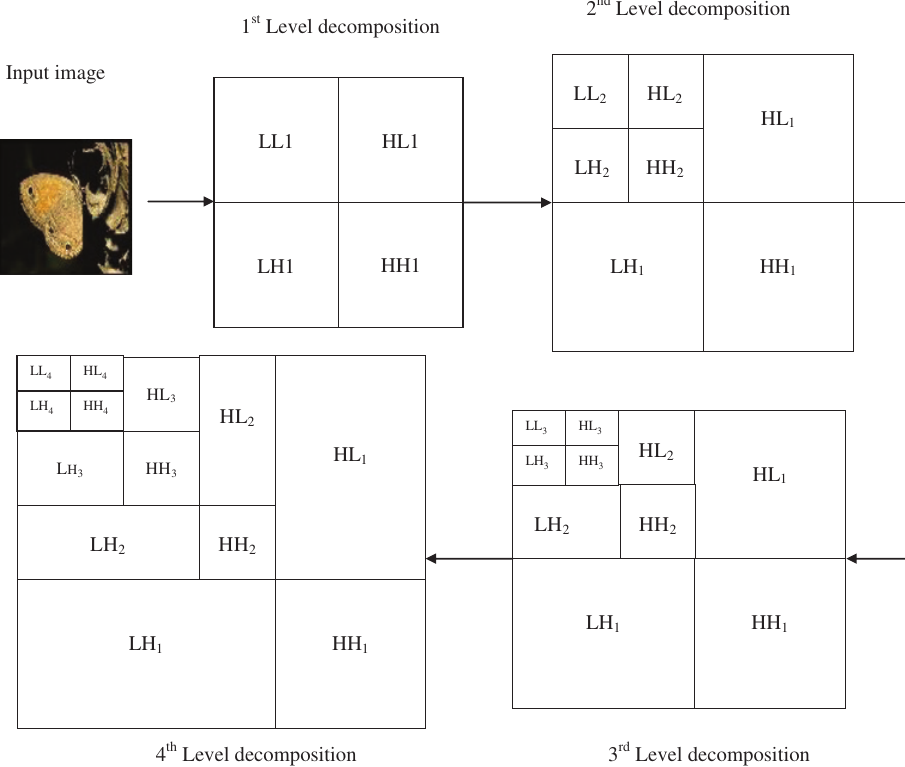
Figure 2: Four-Level Discrete Wavelet